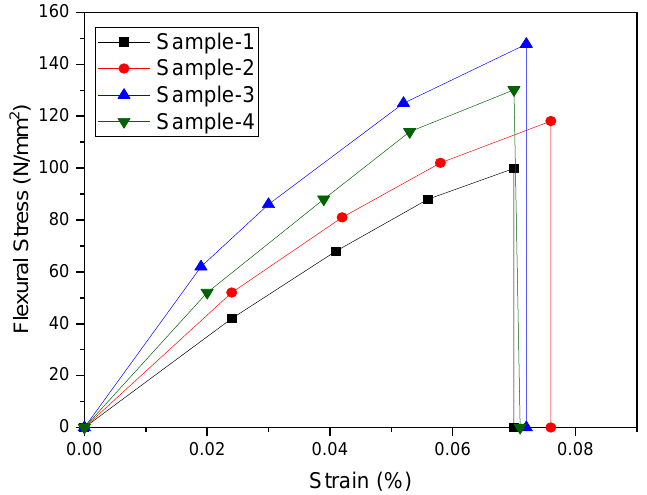
Figure 9. Flexural stress–strain curves for non-functionalized (Sample-1: 0.1 wt.%) and functionalized (Sample-2: 0.1 wt.%; Sample-3: 0.5 wt.%; and Sample-4: 1.0 wt.%) MWCNT nanocomposites.